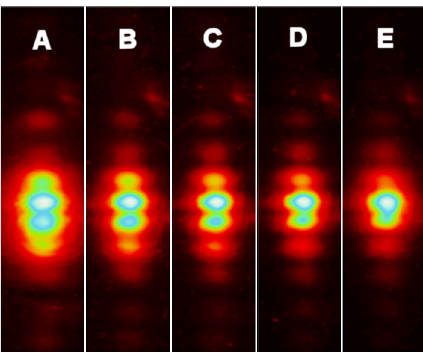
FIG. 9. Images of ODRI angular distribution for different posi- tions of the beam with respect to the center of the 0.5 mm slit. A: (cid:1) 125 (cid:3) m ; B: (cid:1) 50 (cid:3) m ; C: center; D: þ 50 (cid:3) m ; E: þ 125 (cid:3) m .